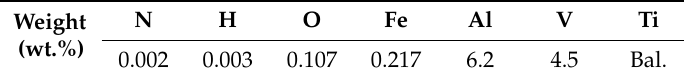
Table 1. Chemical composition of Ti6Al4V alloy rivets.